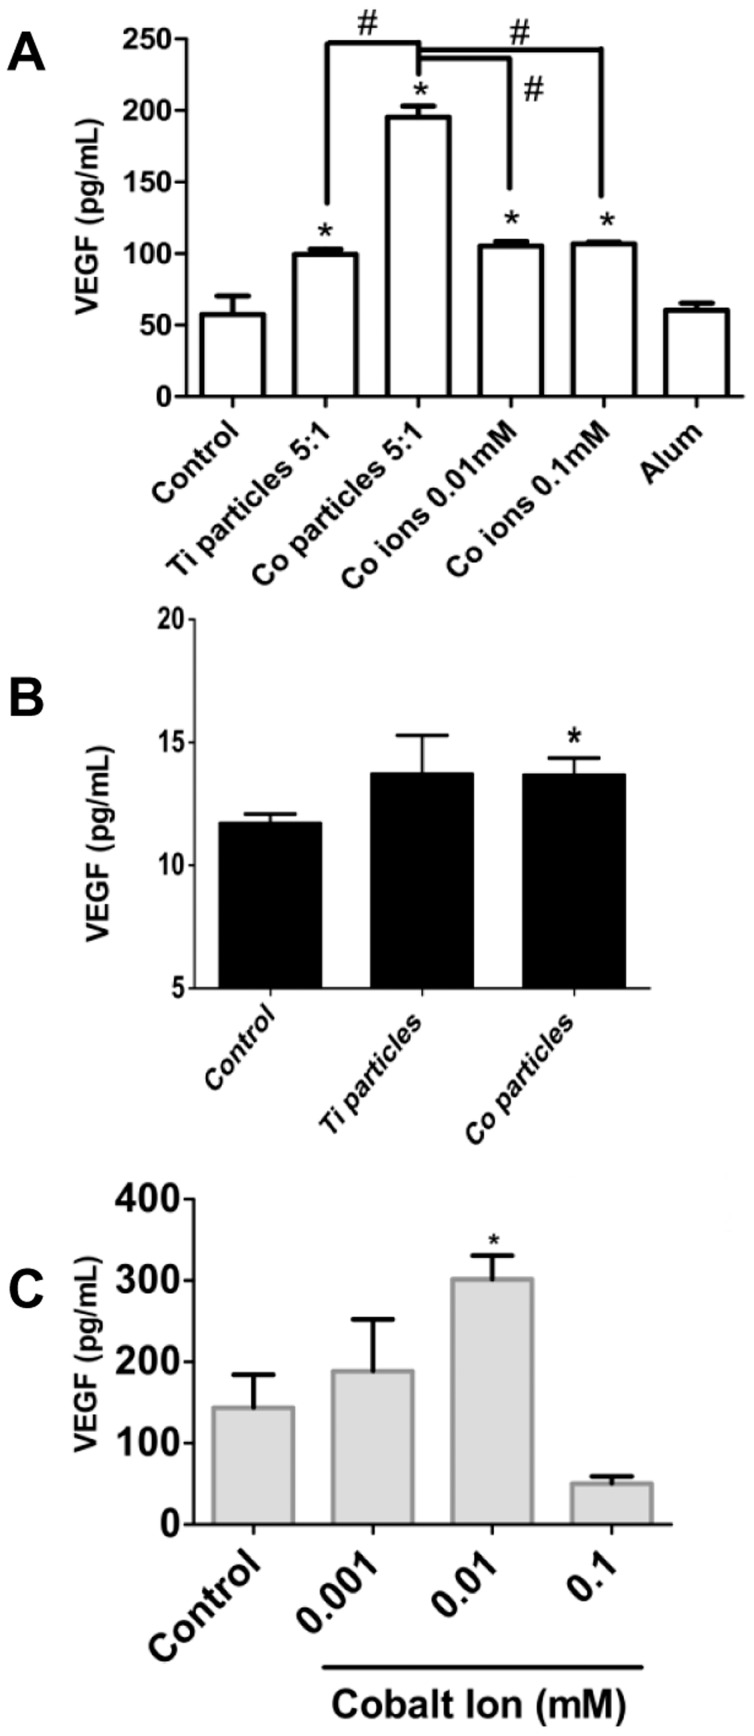
VEGF secretion due to particulate and soluble implant debris.(A) VEGF production was assessed after THP-1 differentiated macrophages were challenged with Ti-alloy (1.2 µm) and Co-alloy (0.9 µm) particles at 5∶1 (particles∶cell) ratio and with 0.01 mM and 0.1 mM CoCl2 for 16 hours and was quantified by ELISA. (B) One of four healthy human subjects (without an implant) demonstrated increased macrophage VEGF response to particle challenge with Ti-alloy and Co-alloy particles at 10∶1 ratio (particles∶cell), ELISA as early as 6 hrs. (C) One of n = 4 healthy human subjects (without an implant) demonstrated increased macrophage VEGF response to challenge with 0.001 mM, 0.01 mM, and 0.1 mM CoCl2 for 16 h. Culture supernatants were analyzed for VEGF by ELISA. Note: * p<0.05, Student's t-test compared to respective untreated controls, # p<0.05 ANOVA.